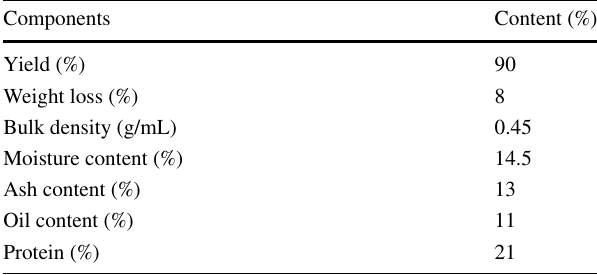
Table 2 Physicochemical characteristics of Brachystegia